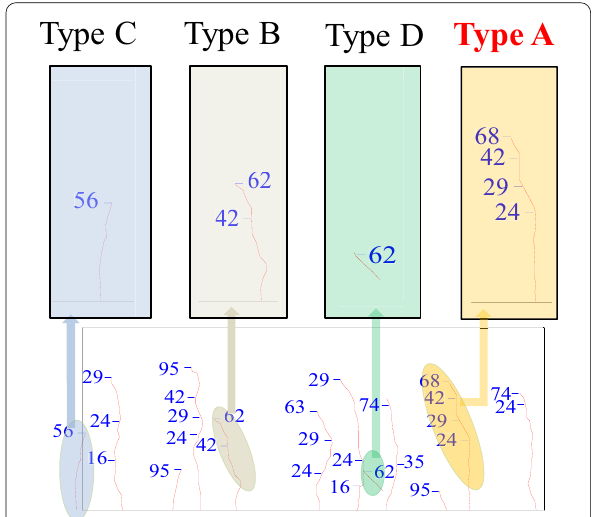
Fig. 6 Crack classification.